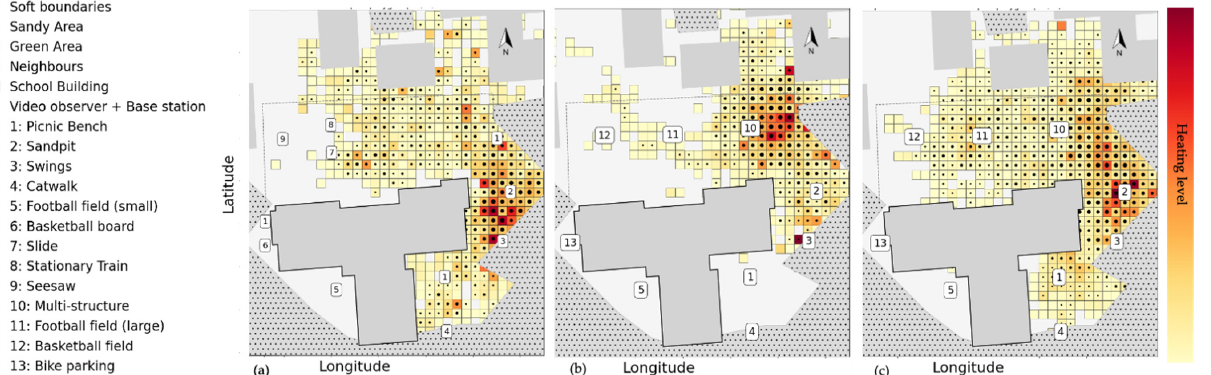
Figure 5. Young children’s heatmap, analysed via GPS data in school B (a) before the renovation, they were attracted to the newly added structure, (b) after the renovation, and then back to their old habitat during (c) the follow-up. The colour bar shows the duration of the visit. The warmer the colour (following the colour bar from yellow to red), the higher the duration of visits by children. The black dots indicate the number of children in each segment. The larger dots show a higher number of children in that spatial bin.